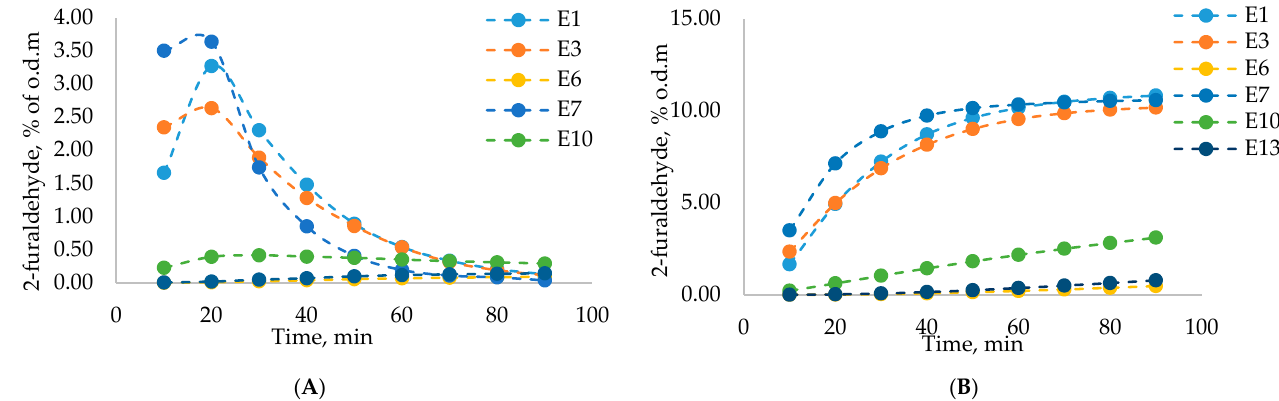
Figure 3. Dynamic 2-furaldehyde yield (% of o.d.m.) at individual time increments ( A ) and total 2-furaldehyde yield (% of o.d.m.) ( B ).